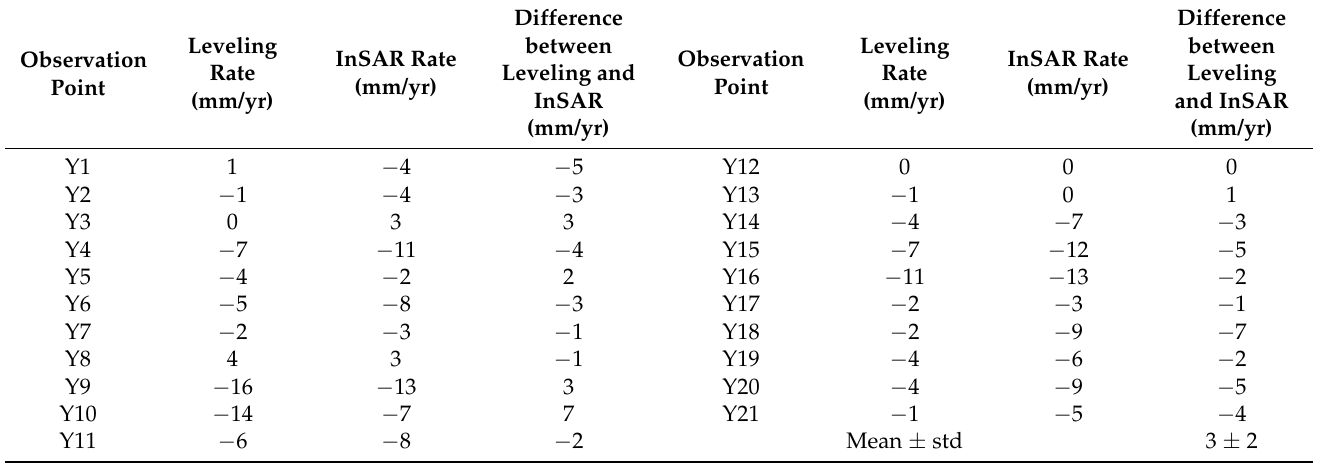
Table 3. Comparison results of the long-term deformation rate measured by leveling and the linear deformation rate of